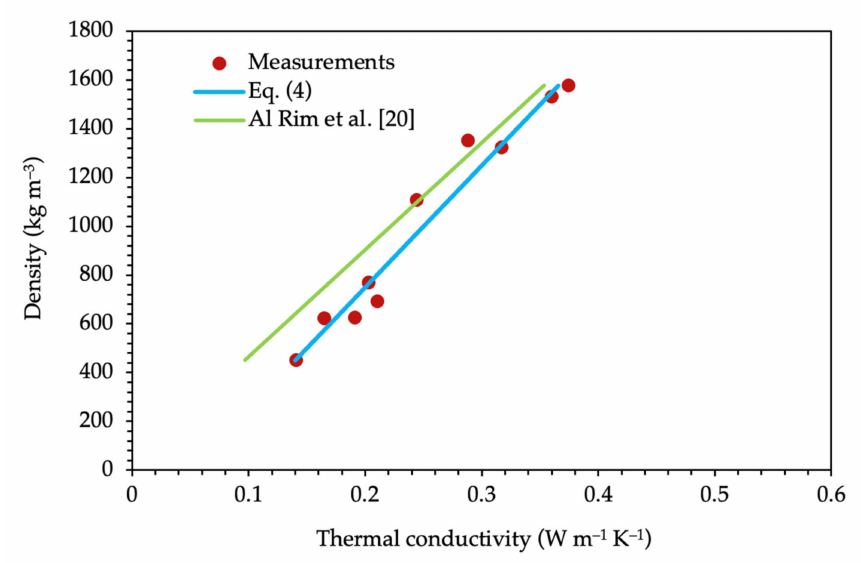
Figure 12. Density and heat capacity of the cob samples versus thermal